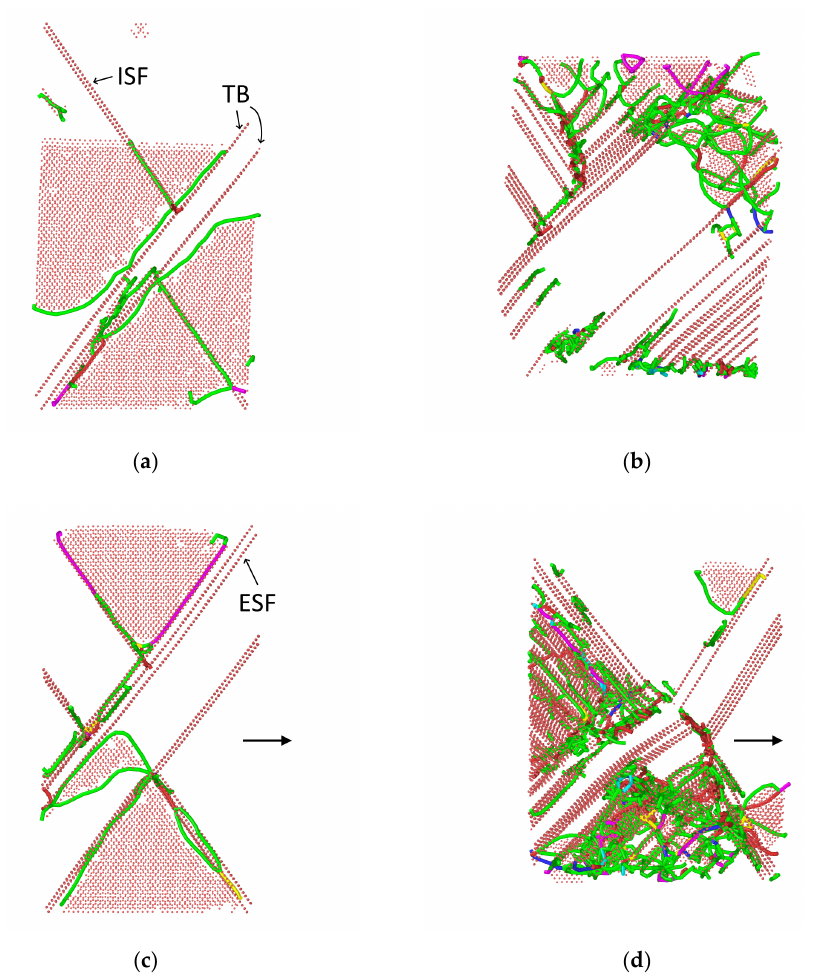
Figure 10. The deformation structure of simulated [001]-single crystal: ( a , b ) the case of free lateral faces; ( c , d ) the constrained deformation conditions (the arrow indicates the direction from the free face); ( a , c ) ε = 7%, ( b , d ) ε = 24%.